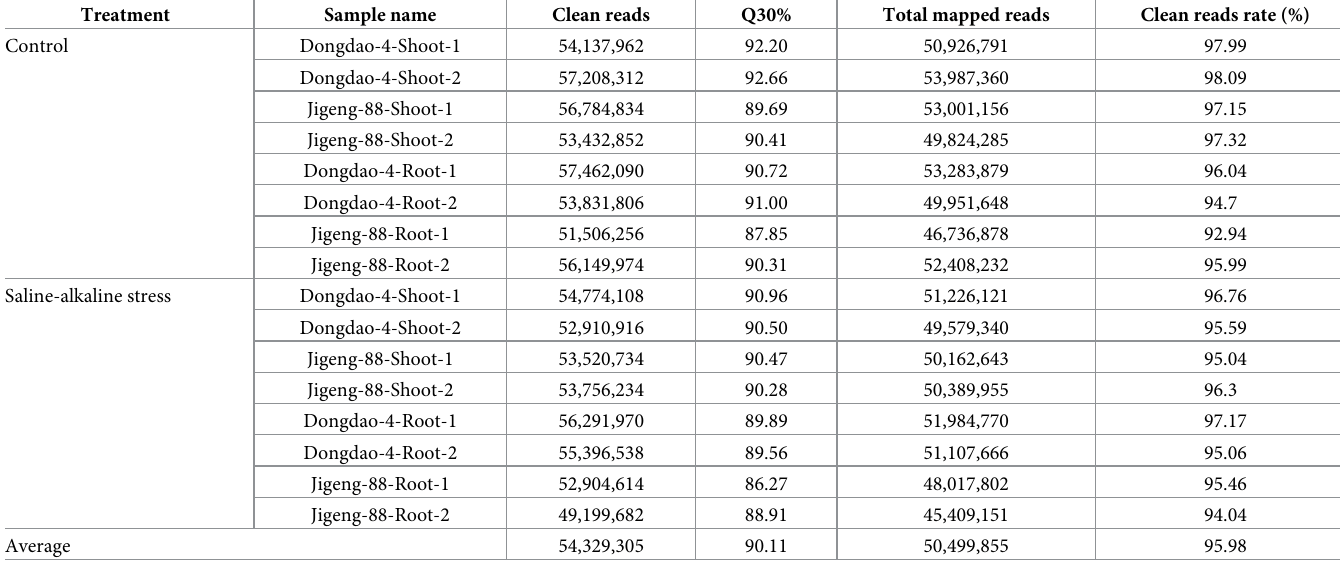
Table 1. Summary of sequencing results and their matches in the Oryza sativa japonica .